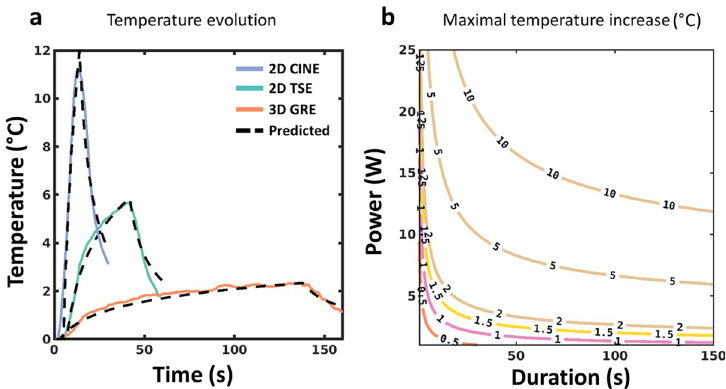
Fig 8. Prediction of maximal temperature rise for other acquisition sequences. (a) Predicted (dashed lines) and measured temperature evolution by the optical fiber for the 2D cine (solid blue curve), the 2D TSE (solid green curve) and 3D GRE sequences (solid orange curve). (b) Contour plot of isotherms showing the predicted maximal temperature increase as a function of the duration and power of a MRI acquisition sequence. Polynomial functions displayed in Fig 7 were used in the